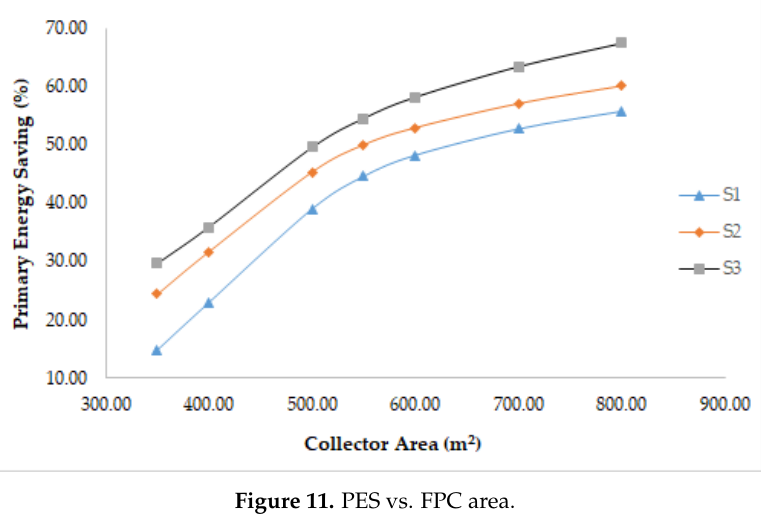
Figure 11. PES vs. FPC area.